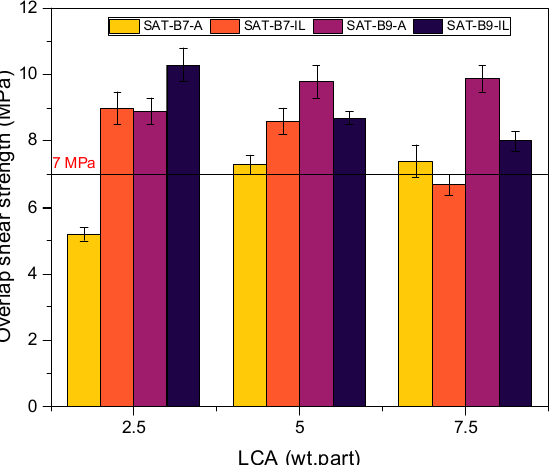
Figure 9. Overlap shear strength of Al/SAT/Al joints (after thermal curing at 180 °C for 60 min) in relation to the latent curing agent type and content in SATs.